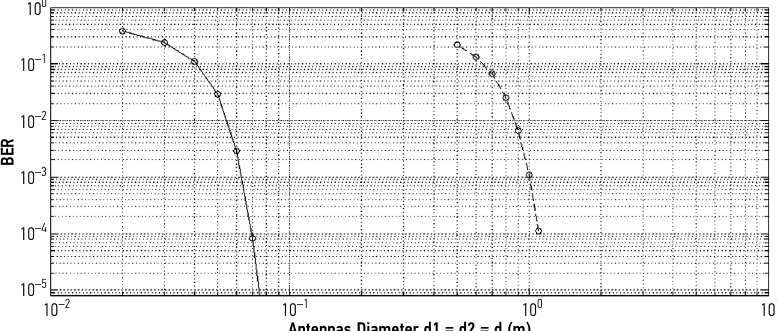
Fig. 4. Dependence of error probability for a BPSK modulation scheme on satellite and aircraft antennas diameter: circles – with convolutional coding (rate 3/4, constraint length K = 7); receiver noise temperature is 20 K (dashed lines) and 290 K (solid lines); phase and frequency offsets are equal to zero; HPA back-off level is 7 dB; free space path loss is 250